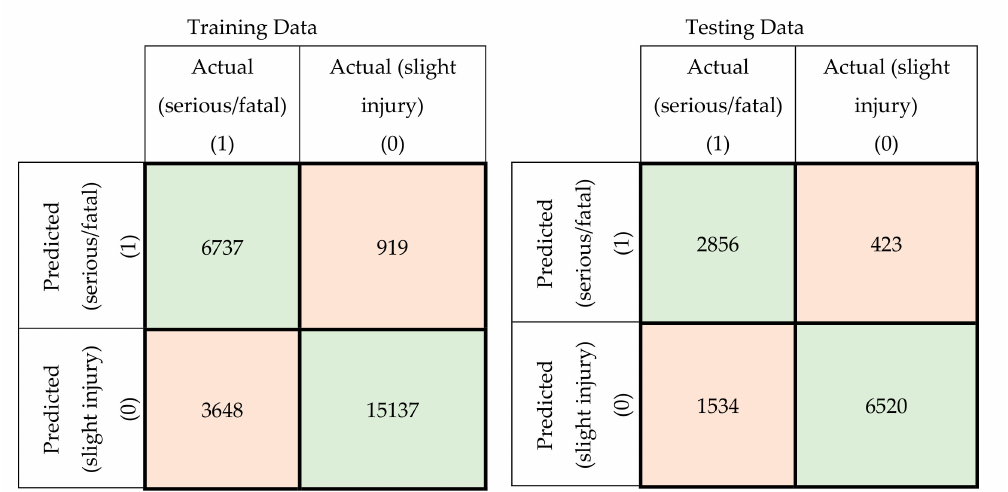
Figure 7. Confusion matrices for the MLP-NN model using principal components (training and testing data).